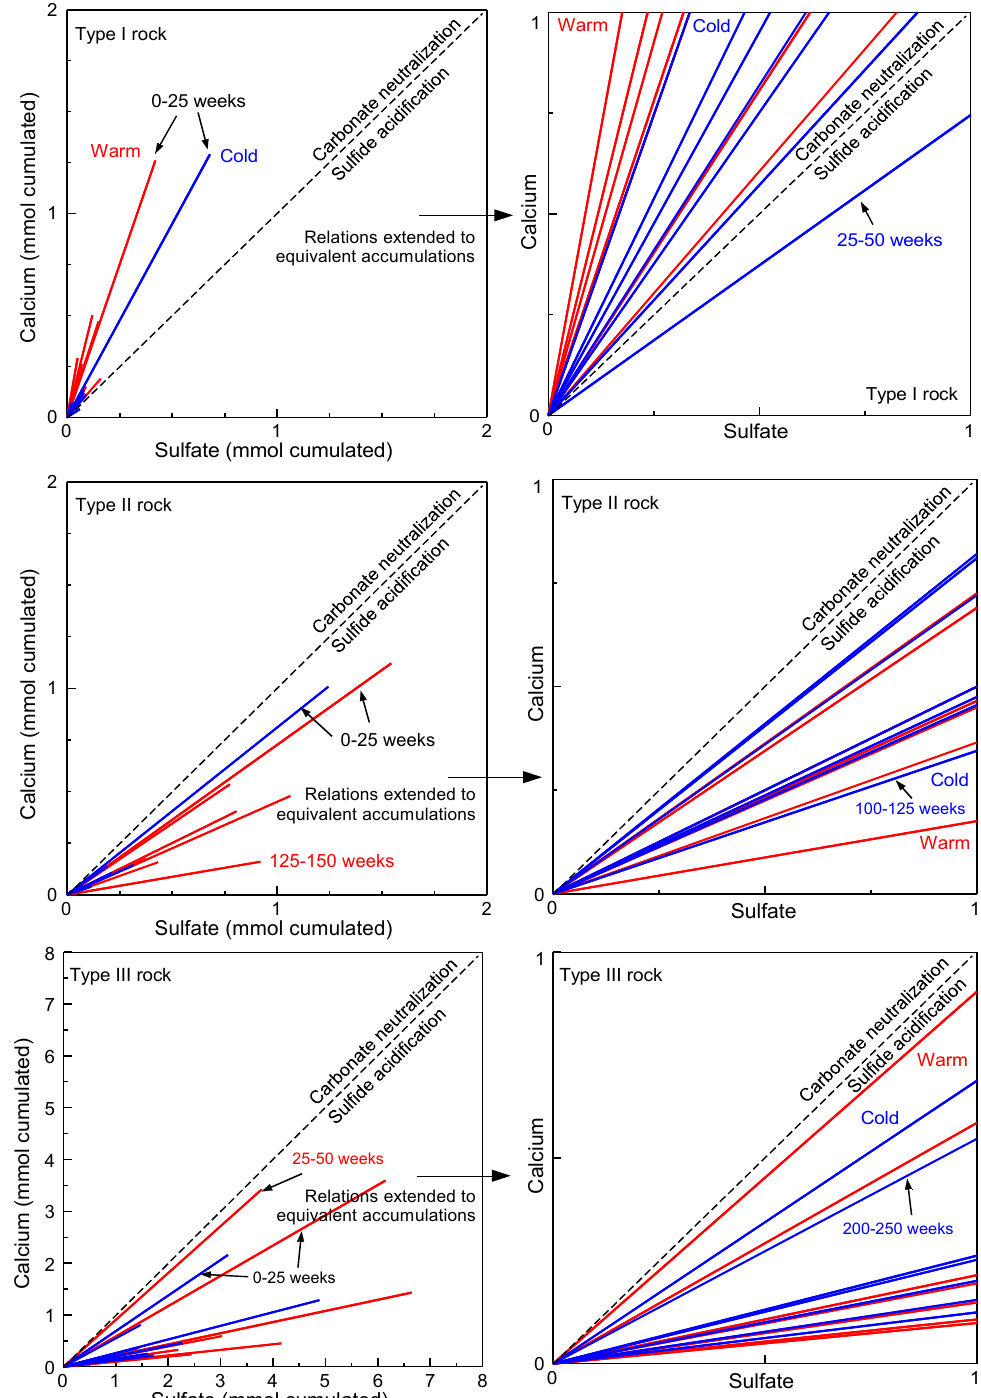
Figure 5. Acid generation-neutralization relations for cumulative loads of Ca and SO from warm and cold humidity cells during intervals of weeks 0–25, 25–50, 50–100, 100–125, 125–150, 150–200, and 200–250. Week intervals above the neutralization-acidification line indicate continued stable pH conditions (neutralization), and intervals below the line indicate possible decreasing or continued acidic pH conditions (acid generating). Select intervals are highlighted to indicate periods of early or greatest acidification. The Ca and relations were extended for all intervals to present the acid generation-neutralization SO 4 relations on a similar scale (not dependent on load